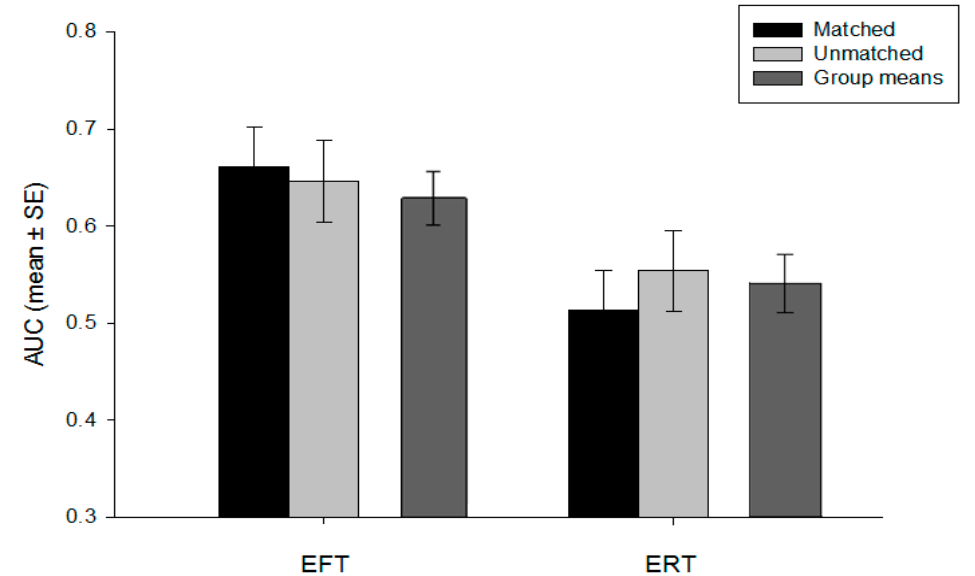
Figure 1. Area under the curve (AUC) values (mean +± SE) for the discounting of delayed rewards as a function of group.